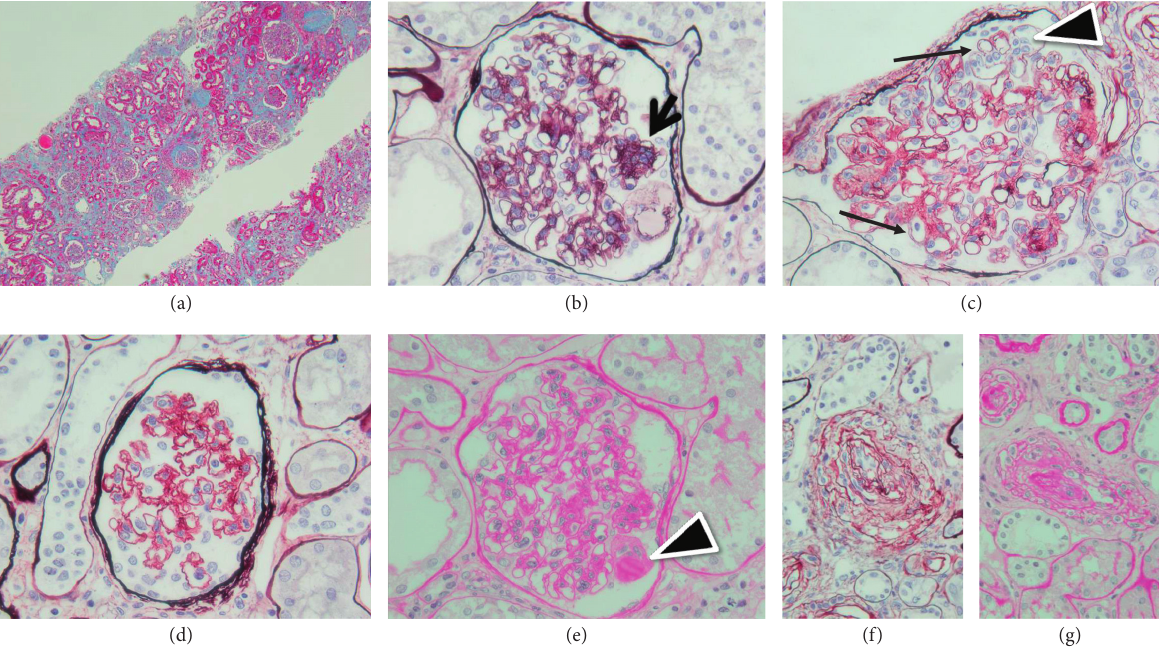
Figure 2: (a) Light microscopy of the biopsied sample (Masson’s trichrome stain, original magnification × 48). (b) Segmental endocapillary hypercellularity (arrow) (periodic acid-silver methenamine stain, original magnification × 400). (c) Focal double contours without spike formation (arrows) and mesangiolysis (arrowhead) (periodic acid-silver methenamine stain, original magnification × 400). (d) Wrinkling of the glomerular basement membrane (periodic acid-silver methenamine stain, original magnification × 400). (e) Segmental thrombus in one glomerulus (arrowhead) (periodic acid-Schiff stain, original magnification × 400). Some arterioles revealed thickness of the arterial intima and narrowing or complete obstruction of the vessel lumina. (f) Periodic acid-silver methenamine stain, original magnification × 400. (g) Periodic acid-Schiff stain, original magnification × 400.